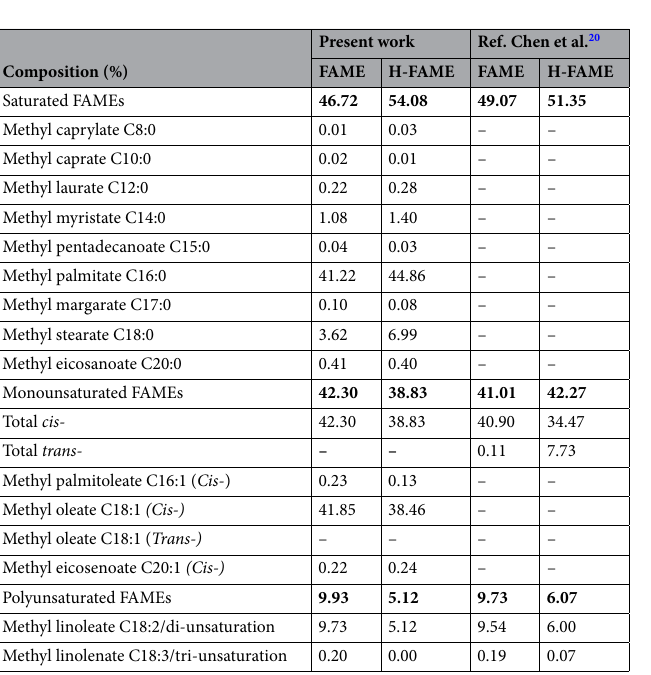
Table 1. Compositions of FAME and H-FAME determined by GC–MS (100 W, 1 mm gap, 80%H 2 , room temperature and 5 h) compared to catalytic